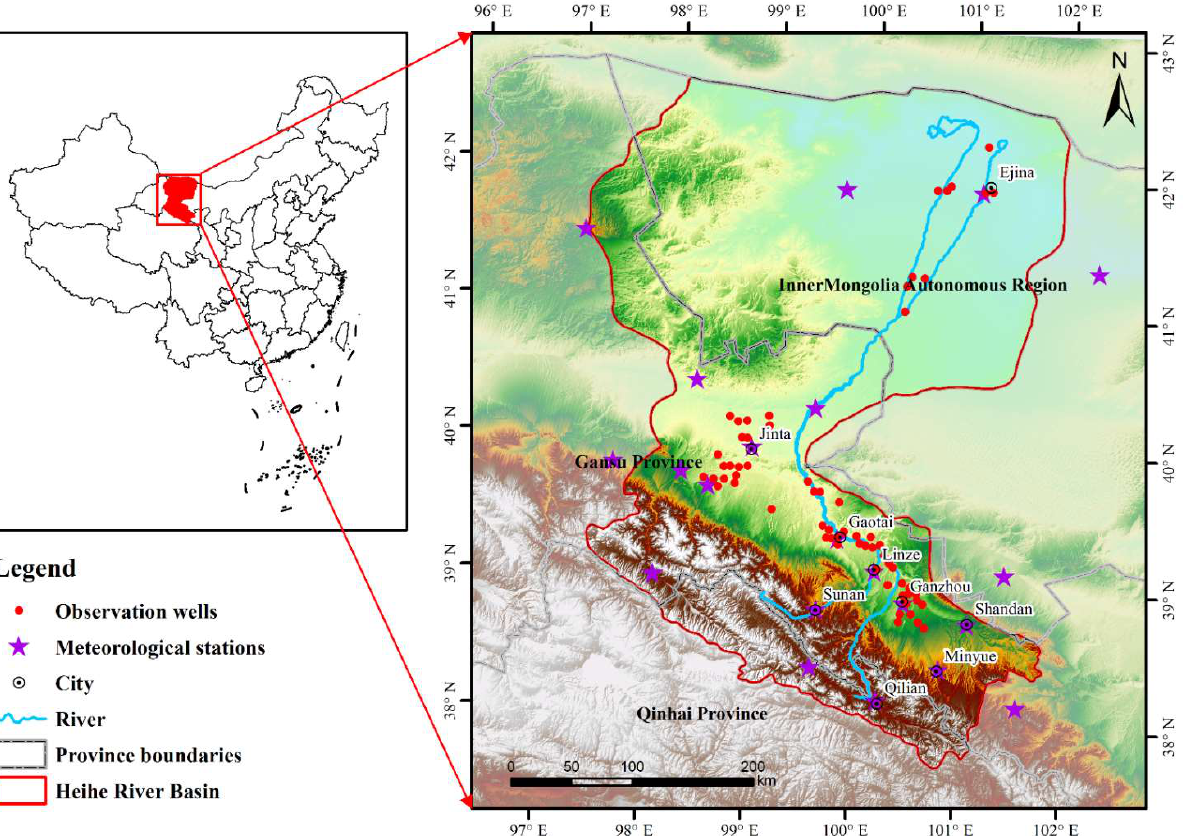
Figure 2. The research area of the middle and lower reaches of the Heihe River.